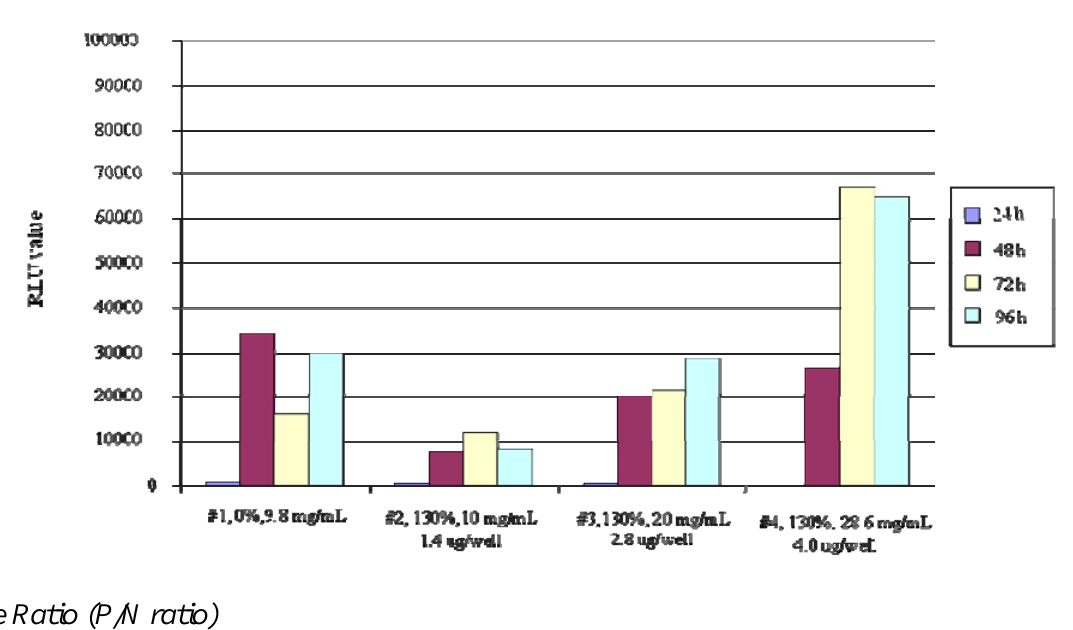
Transfection of COS-7 cells with sample 1 of DEAE-dextran and DEAE- dextran-MMA graft copolymer. The grafting rate is 130% for sample 2 at 10 mg/mL, sample 3 at 20 mg/mL, and sample 4 at 28.6